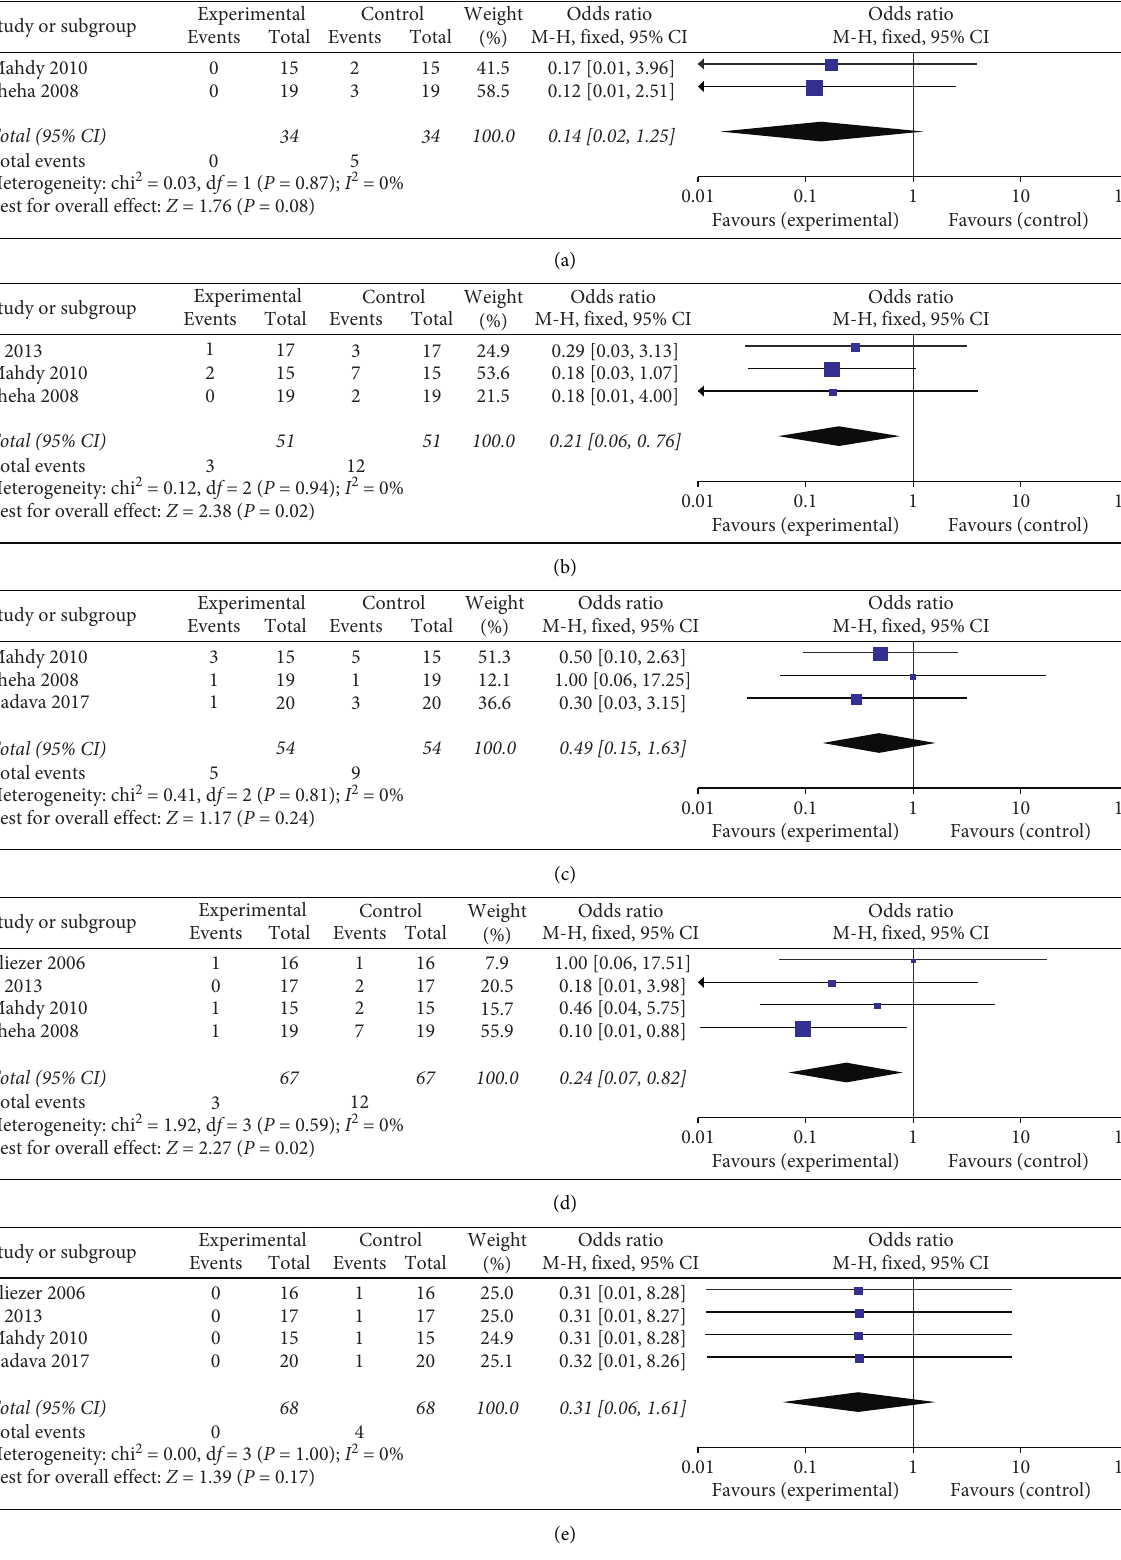
Figure 6: Forest plot comparison of complications after treatment in the AMTand control group. (a) Hypotony. (b) Flat anterior chamber. (c) Hyphema. (d) Encapsulated bleb. (e) Choroidal